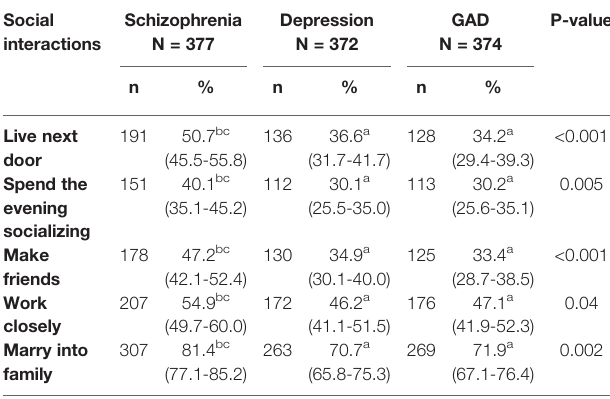
TABLE 4 | Percentage (and 95% CI) of participants who “ probably unwilling ” or “ de fi nitely unwilling ” to have contact with the person described in the vignette.